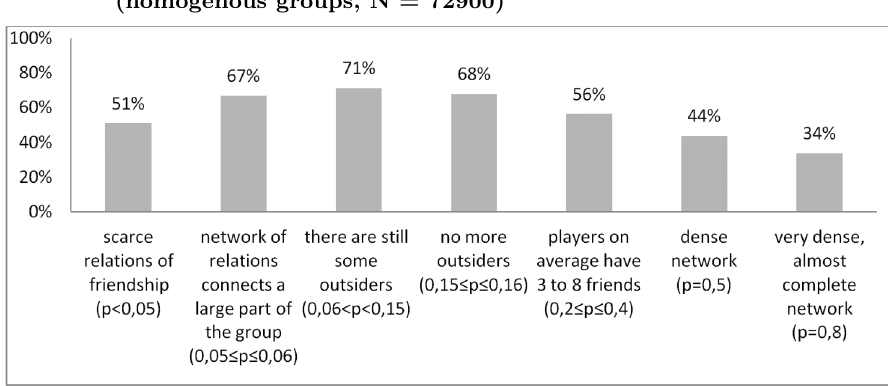
(homogenous groups, N =